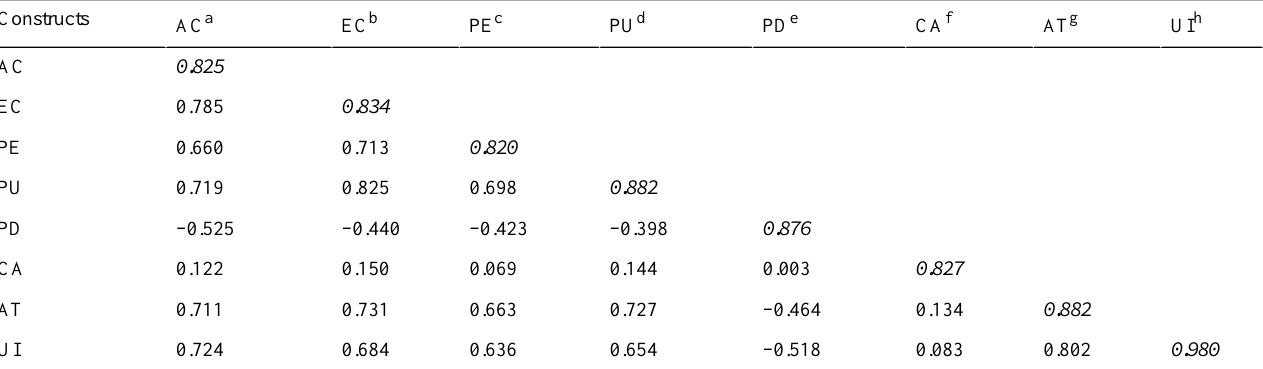
Table 4. Correlation matrix and square root of the average variance extracted. Values in italics are the square root of the AVE for the corresponding